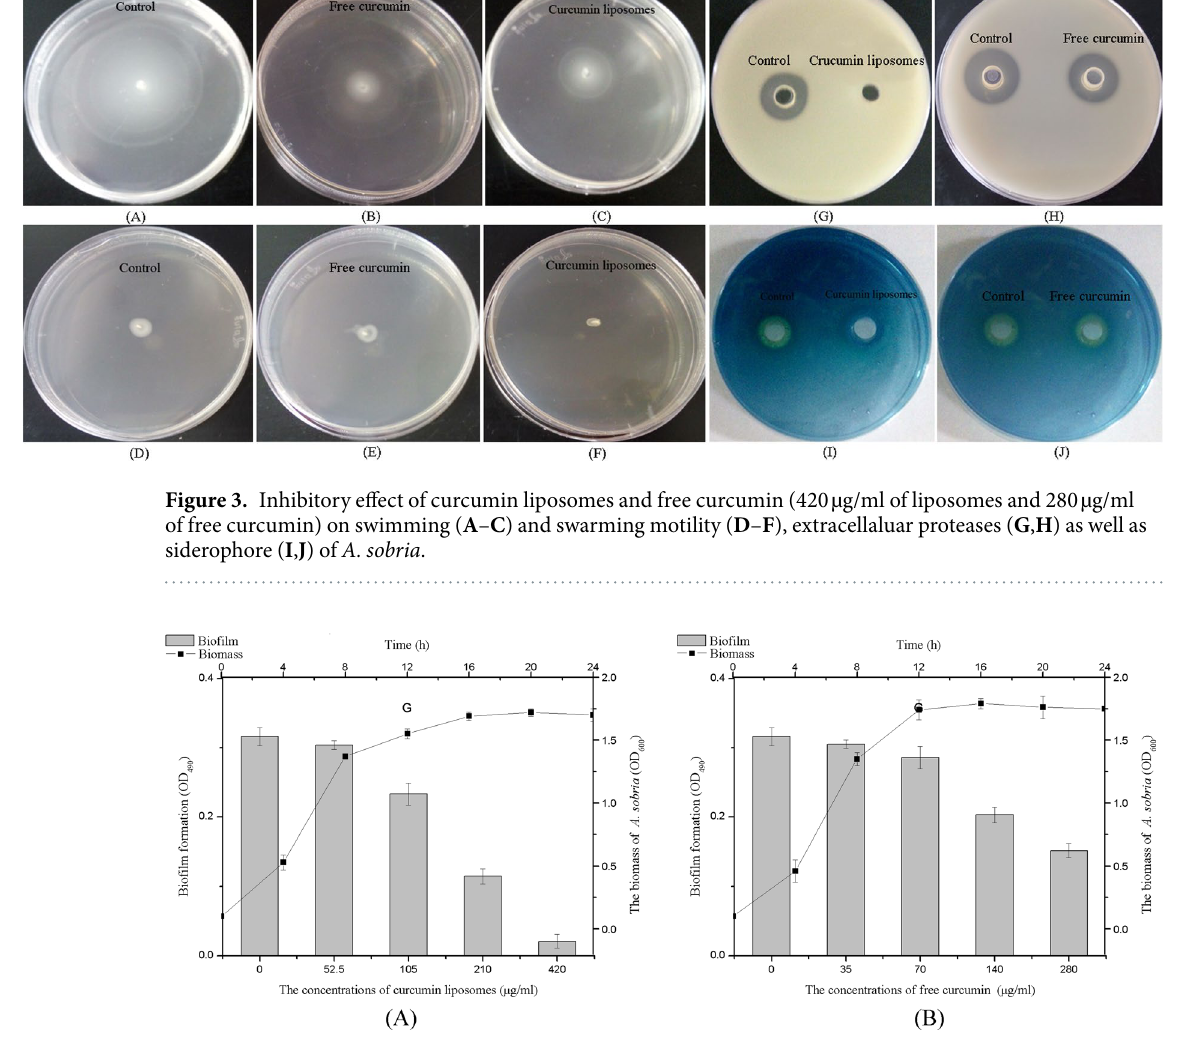
Figure 4. Effect of different concentrations of curcumin liposomes (1) or free curcumin (2) on growth and biofilm formation of A. sobria . Each bar and line represents mean of three replicates and standard